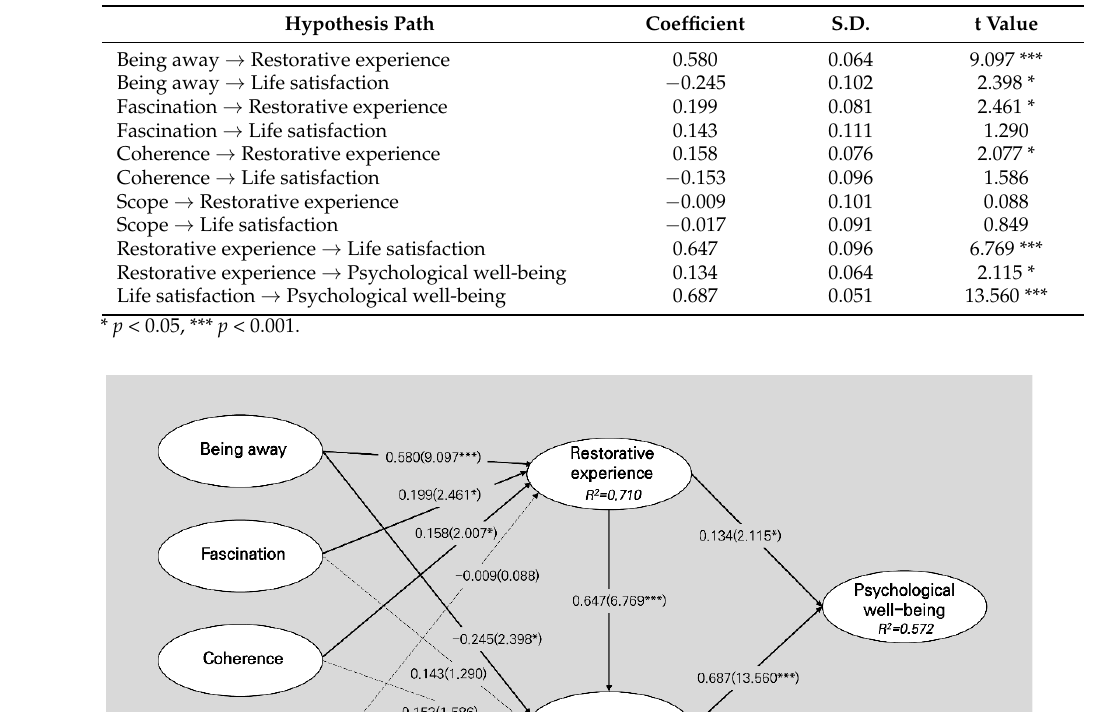
Table 6. Hypothesis analytics.